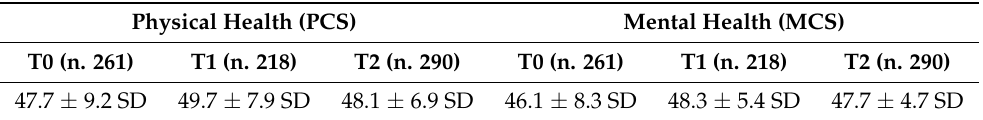
Table 3. Average score SF12 (PCS and MCS) in the three groups of responders recruited at the three time points